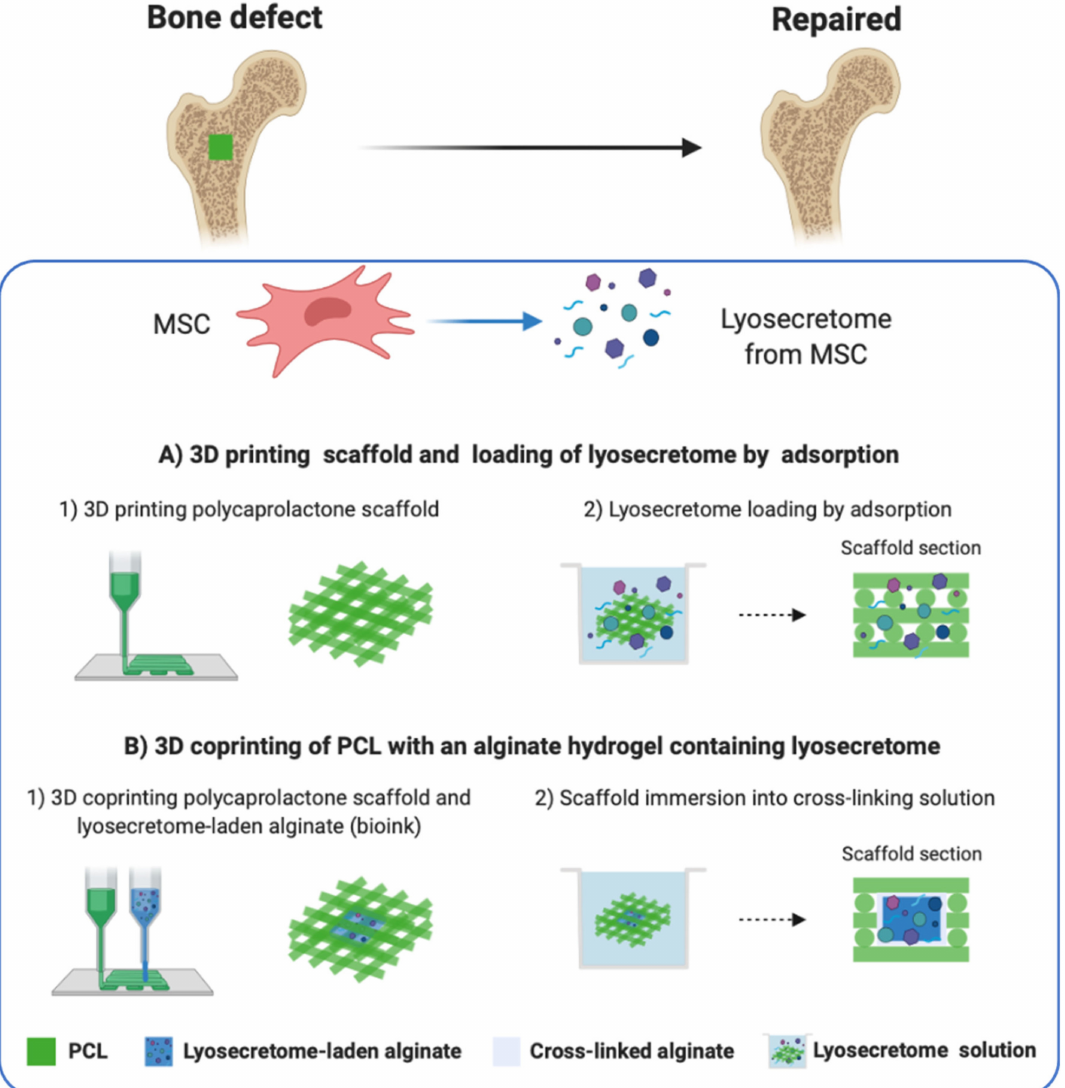
Figure 1. Scheme of the two different strategies investigated in this study: ( A ) 3D printing of the scaffold and subsequent loading of lyosecretome by adsorption. ( B ) 3D coprinting of PCL with an alginate-based hydrogel encapsulating